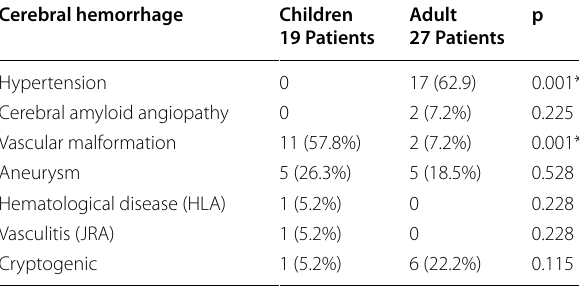
By Chi square test and Fisher exact test, *p value was significant